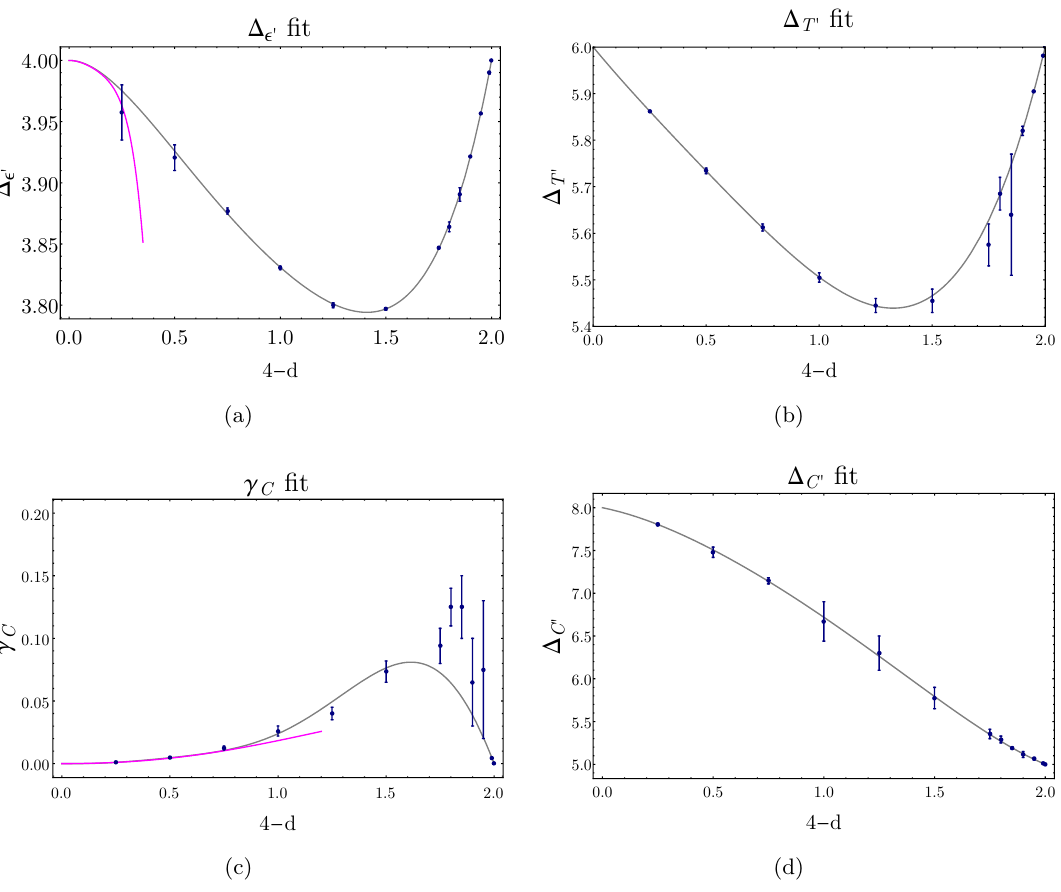
Figure 8 . Polynomial (cid:12)t of (cid:1) (cid:15) 0 ; (cid:1) T 0 ; (cid:13) C ; (cid:1) C 0 ; as functions of y = 4 (cid:0) d . Figures (a) and (c) include the known epsilon expansion